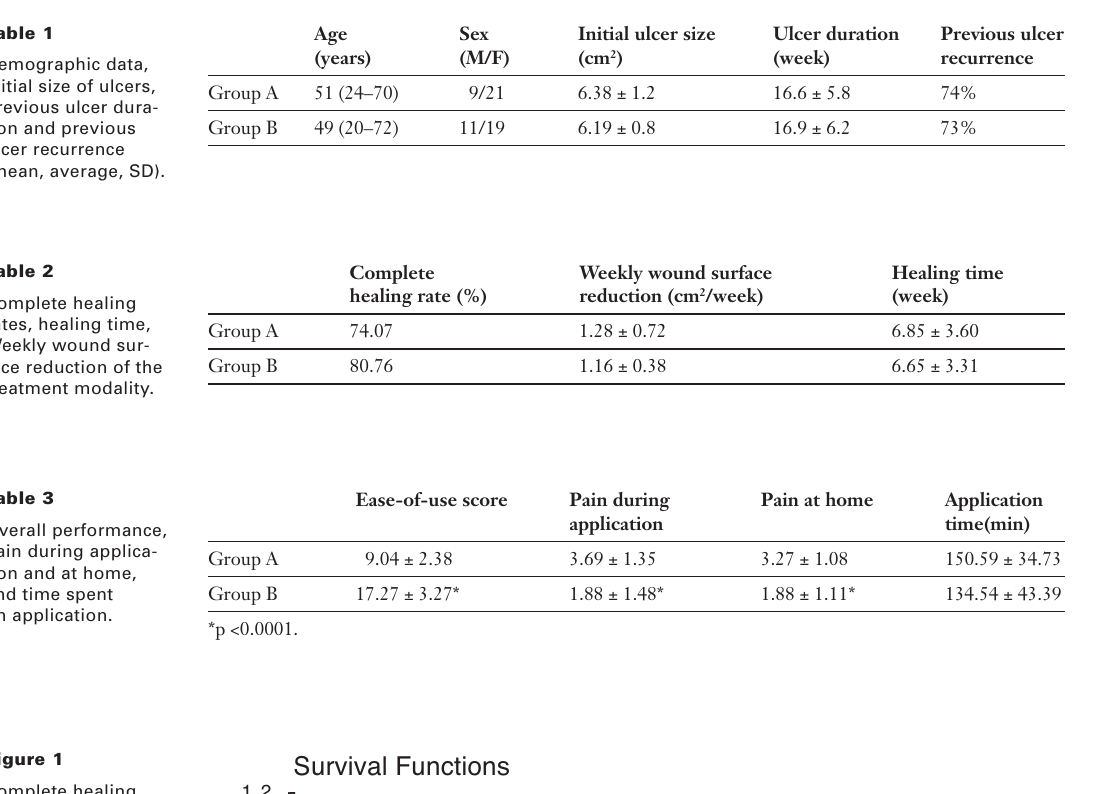
Complete healing rate per week with Kaplan-Meier